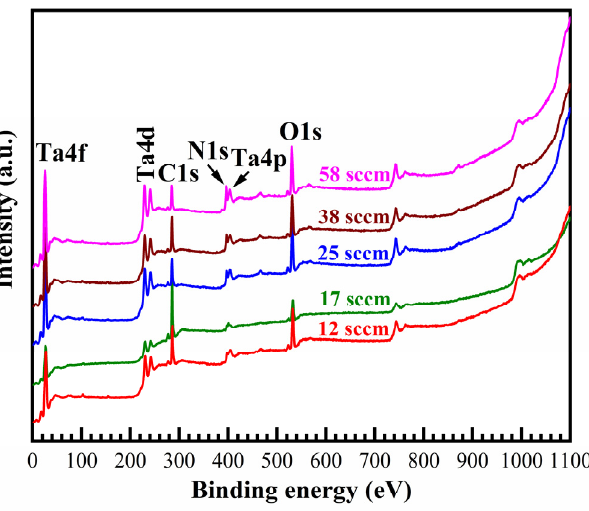
Figure 4. Evolution of the XPS survey spectra in the binding energy range of 0–1100 eV as a